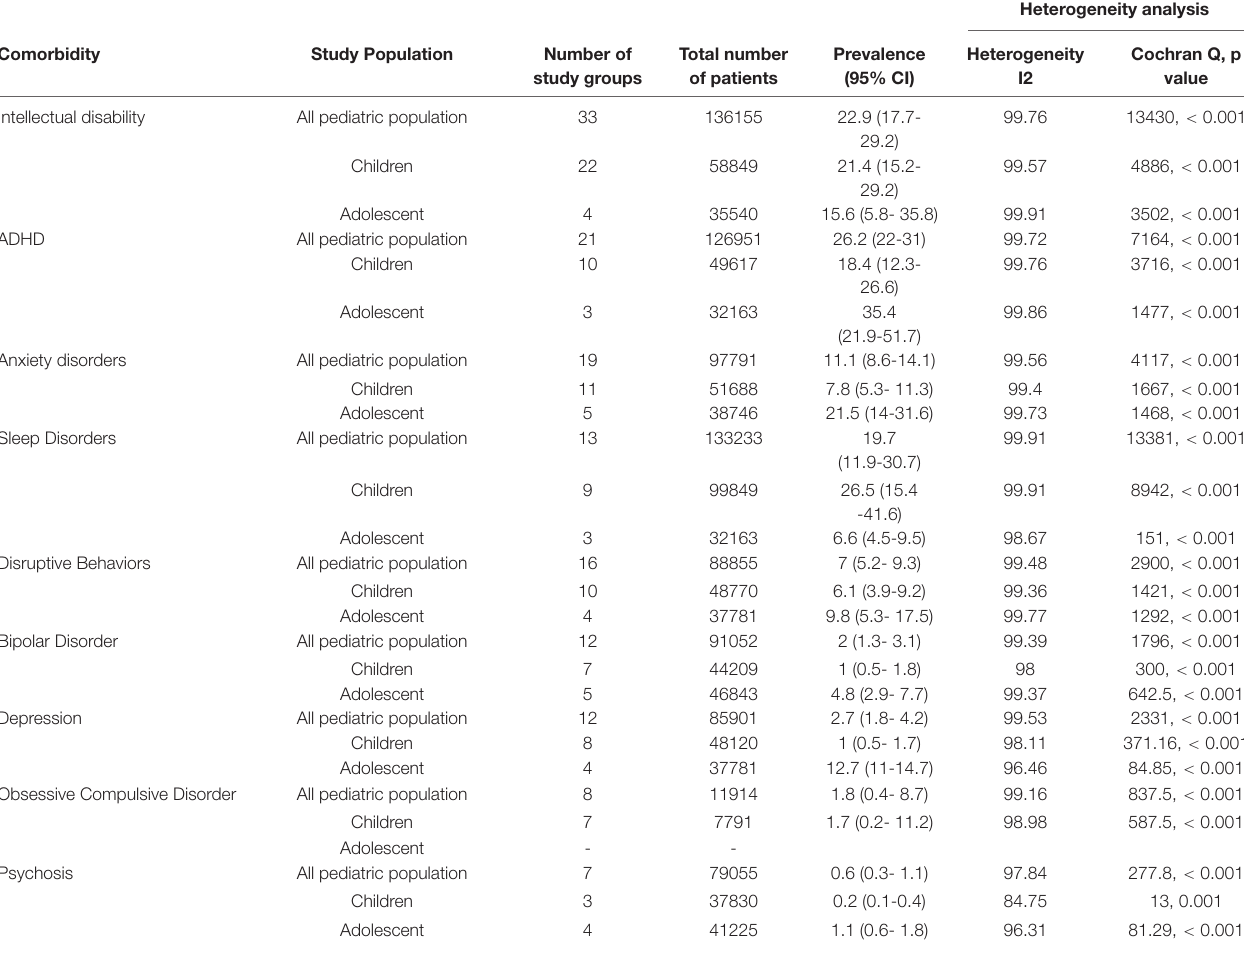
Heterogeneity analysis